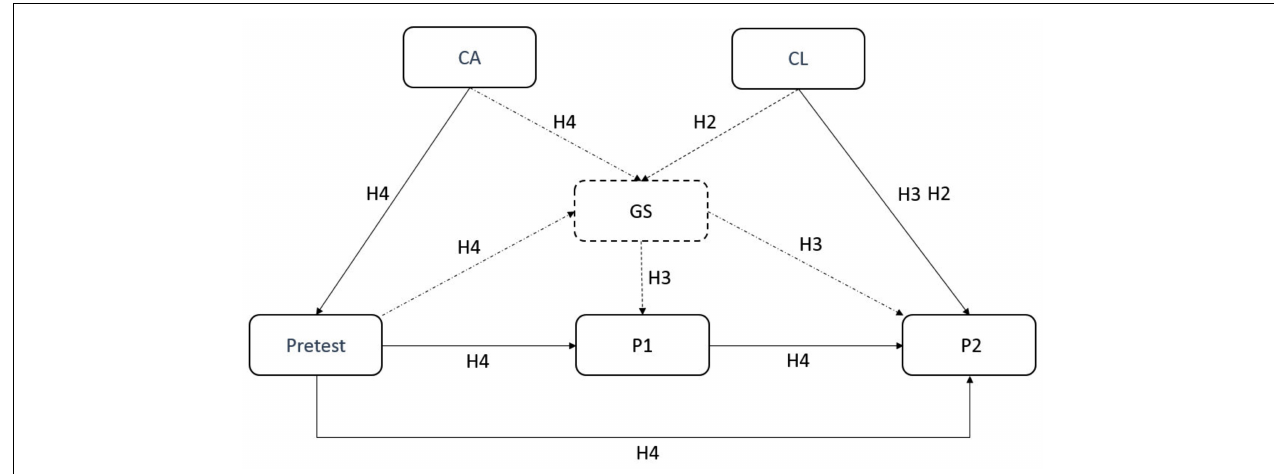
FIGURE 3 | Theoretical path model of expected influences of learners’ prerequisites on short-term and long-term retention in both treatments. P1 = immediate test; P2 = 1-week-delayed test; Pretest = prior knowledge on scientific reasoning skills (CVS); CA = cognitive abilities; CL = cognitive load; GS = self-generation success in (GF) treatment; H1–4 = Hypothesis